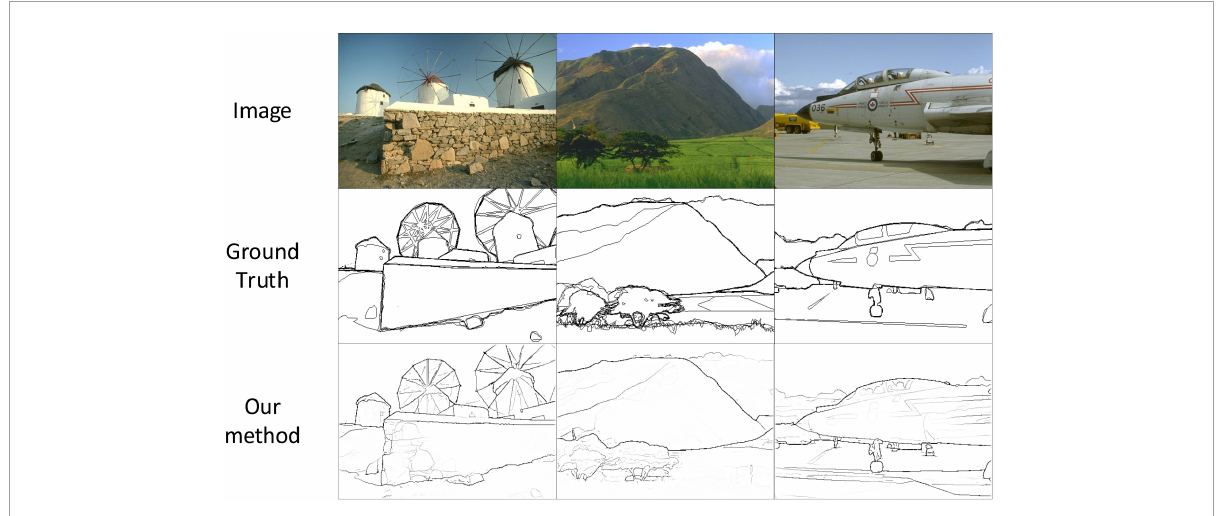
FIGURE1 Partial test results of our method on the BSDS500 dataset. Source photos: BSDS500 dataset - publicly available dataset.